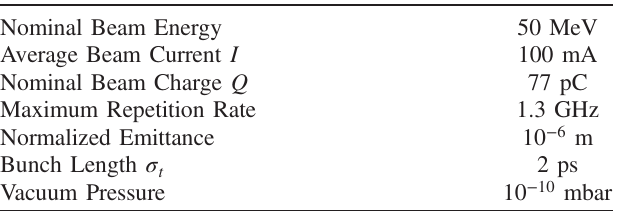
TABLE I. Nominal parameters of